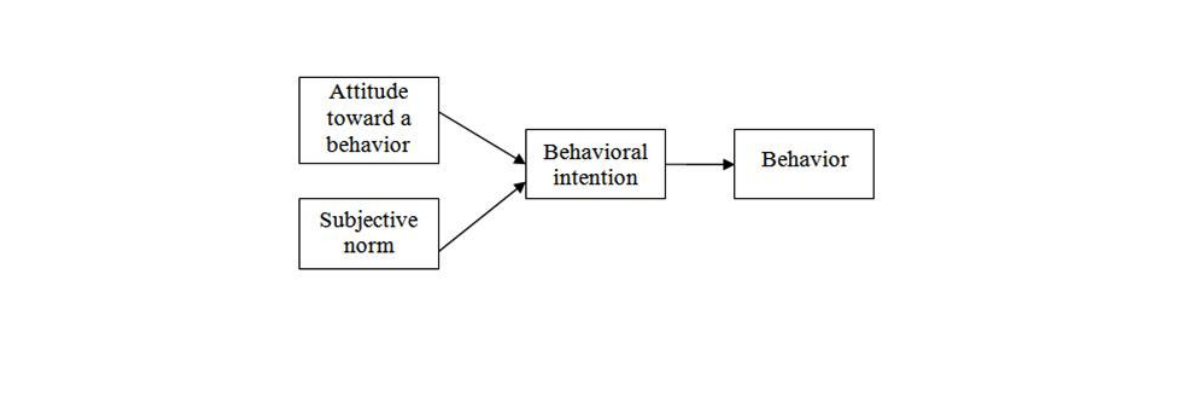
Figure 1. Theory of reasoned